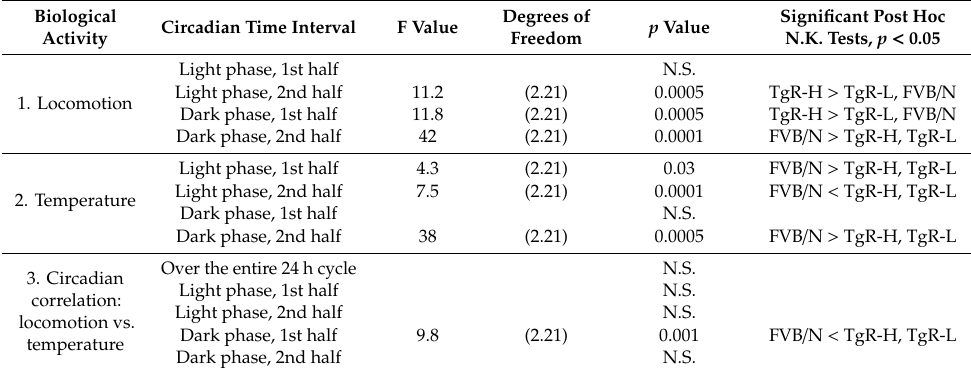
Table 3. Circadian rhythms in naive FVB / N, TgR-L and TgR-H